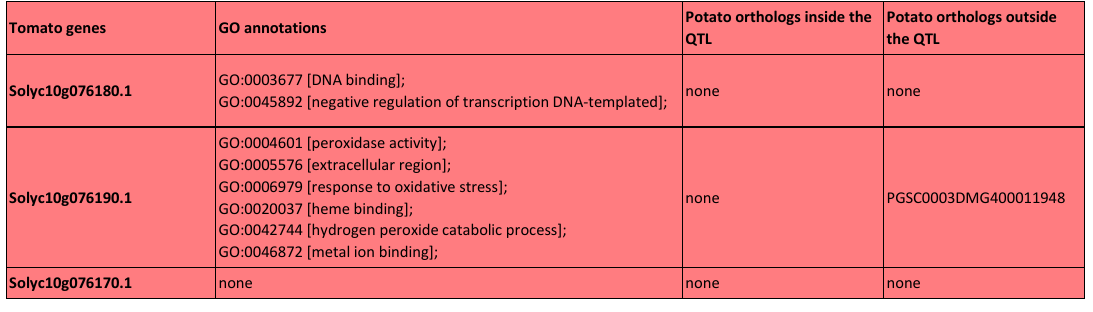
Table 1. Table comparing genes in QTLs associated with (tomato) fruit shape and (potato) tuber shape. Three classes represent (a) genes unique in tomato; (b) genes unique in potato (c) genes mapped in both species. Each row contains a gene ID, GO annotations and orthologs inside/outside a QTL region. The query shows that only three genes are unique in tomato (i.e., Solyc10g076190.1 , Solyc10g076170.1 and Solyc10g076180.1